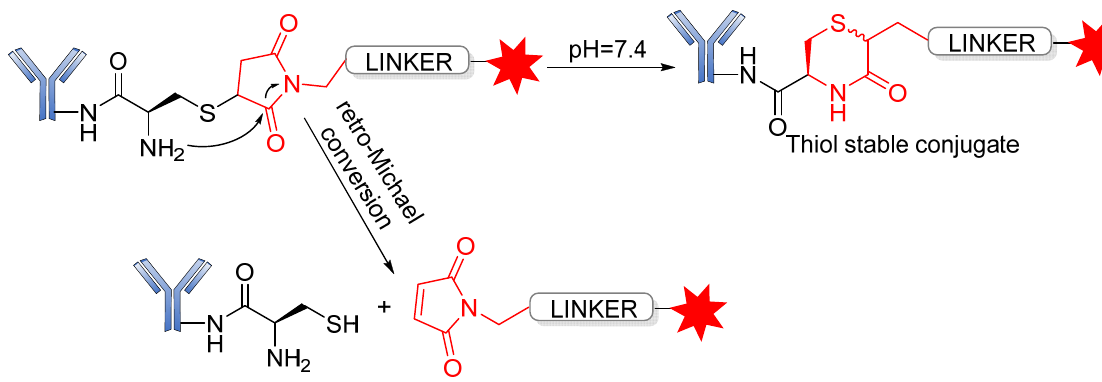
Figure 20. Mechanism for the locking of the thioether conjugation bond via transcyclization.